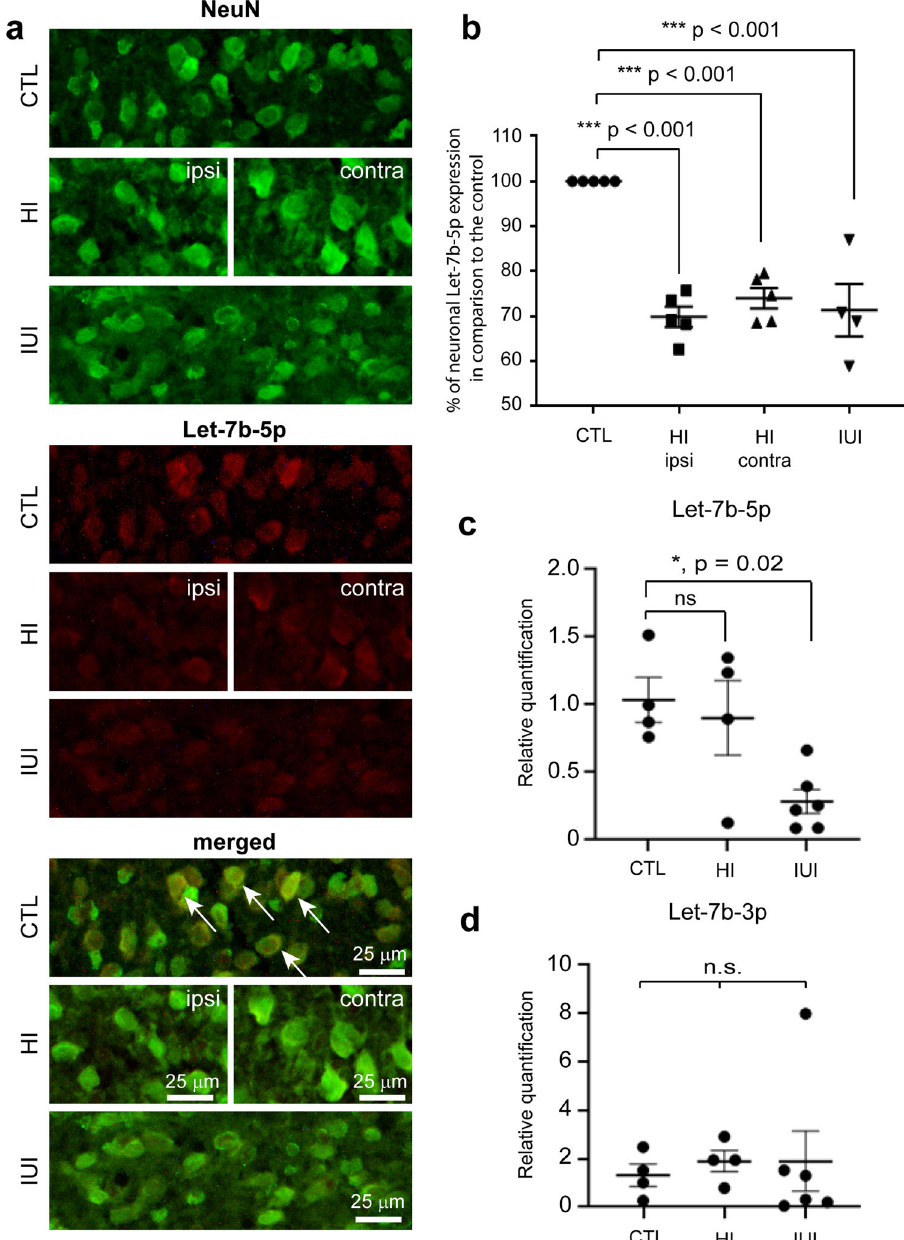
Fig. 7 Expression of let-7b-5p in the cerebral cortex in all animal models. a Images of NeuN positive neuronal cells (green) with let-7b-5p expression (red) and coexpression is shown (yellow) in the cerebral cortex of control (arrows indicate coexpression), hypoxic-ischaemic in the ipsilateral and contralateral region and intrauterine in fl ammation model. b Graph showing the statistical signi fi cance between the neonatal encephalopathy models vs. control groups ( n = 4 – 6 per group). c – d Relative expression (2 - ΔΔ Ct ) of let-7b-5p ( c ) and let-7b-3p ( d ) in peripheral blood in the form of DBS from the rat animal models. Error bars represent mean with SEM. ns not signi fi cant, * and *** denote signi fi cant p <0.05 and p <0.001, respectively using ANOVA with Dunnett ’ s multiple comparisons test. Scale bar = 25 μ m. CTL control, HI hypoxic-ischaemic, ipsi ispsilateral side, contra contralateral side, IUI intrauterine in fl